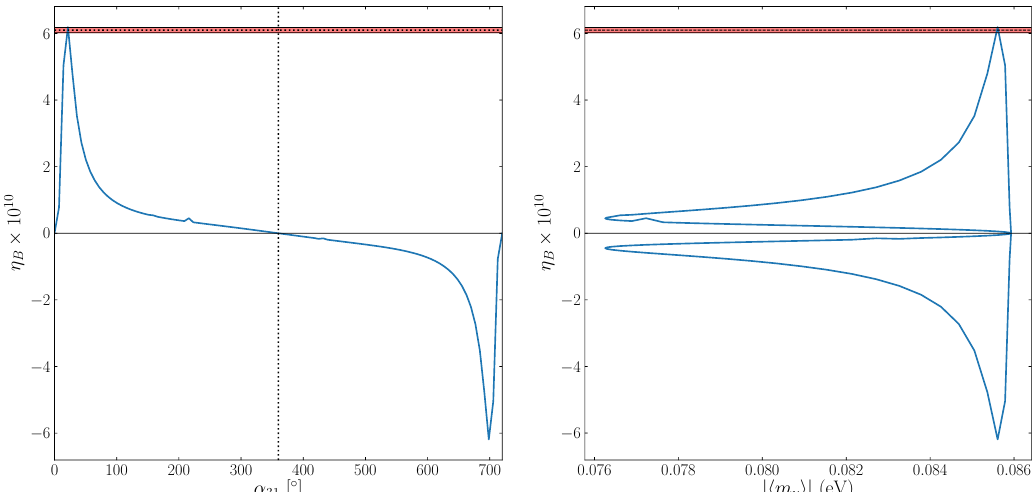
Figure 12 . Leptogenesis at intermediate scales ( M 1 = 7 : 00